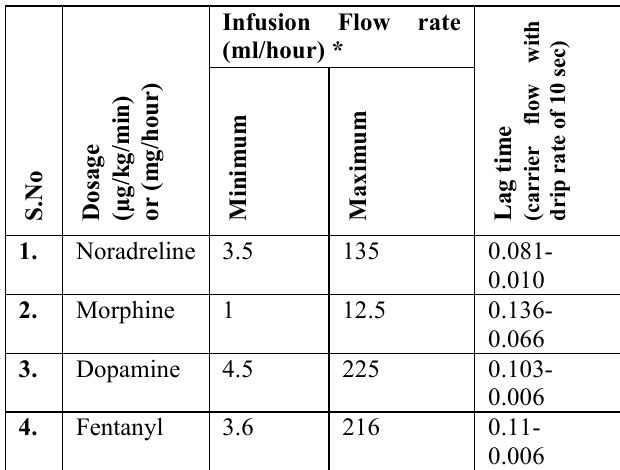
Table 1. Sample for few drugs for a carrier flow rate of 10 and 50